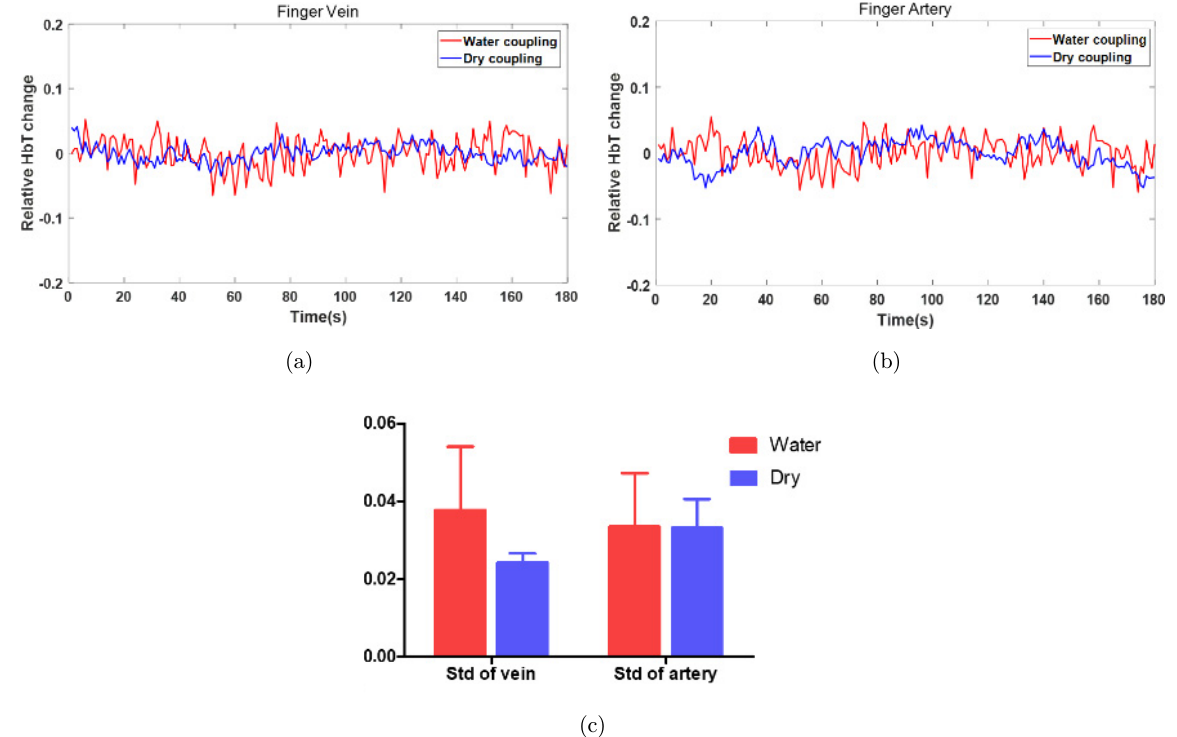
Fig. 6. Blood volume changes over 180 s for the vein (a) and artery (b) when water coupling (red) or dry coupling (blue) was used. (c) Standard deviations calculated for the blood volume change pro¯les shown in (a) and (b). Std: standard